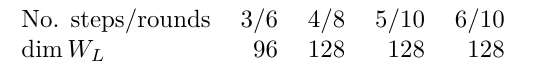
Table 5: Dimensions of W L for Clyde-128 ’s round constants and different No.